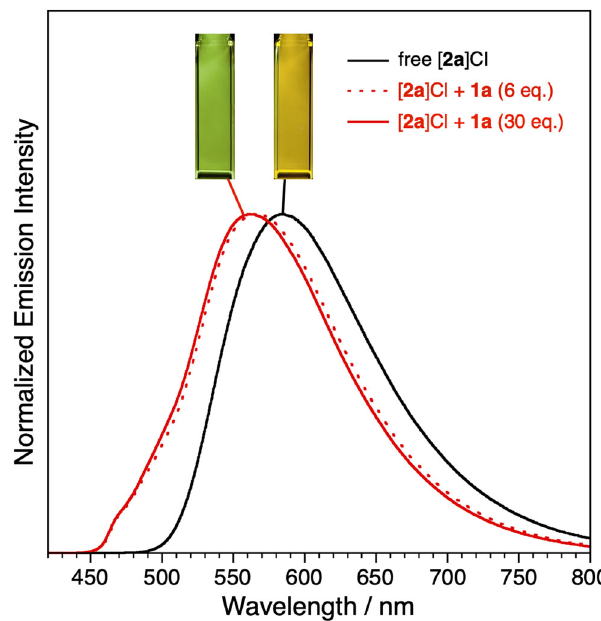
Fig. 4 | Normalized emission spectra of[2a]Cl (10 μ M) with various amounts of resorcin[4]arene monomer 1a (0, 60, 300 μ M). The solutions containing [ 2a ]Cl and 1a were heated at 50°C for 1min before the measurements ( λ ex